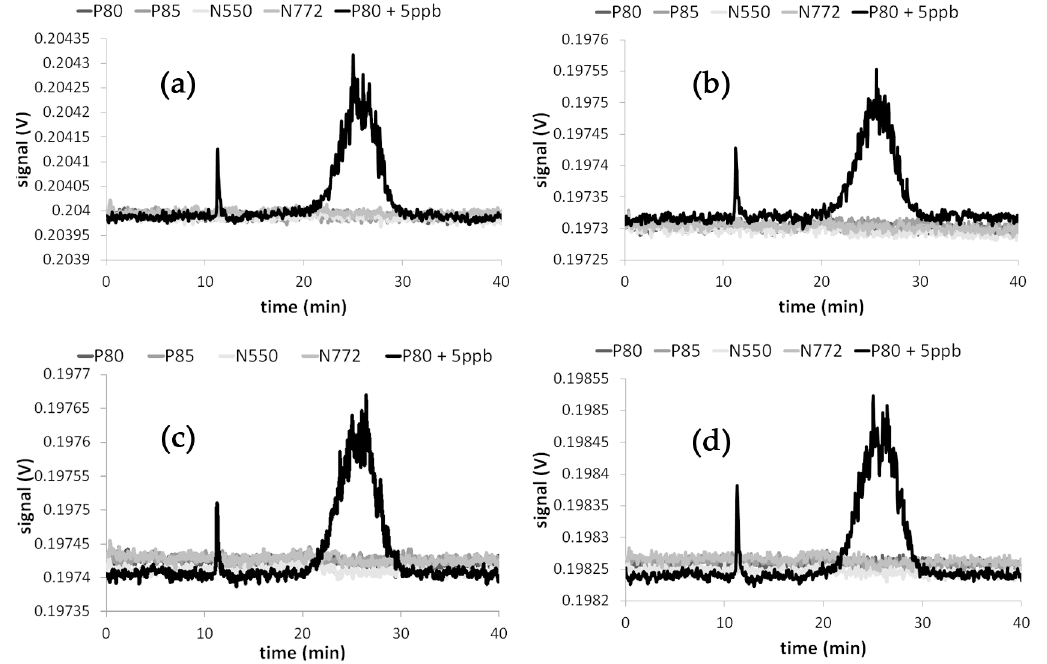
Figure 9. AF4 fractograms of abraded nanocomposites that were pre-stressed by heat ( a ), deep-freezing ( b ), solvent swelling ( c ), and stretching ( d ). The black curves are the fractograms of samples that were additionally fortified with carbon black (in this case PX 80 at 5 ng/mL).